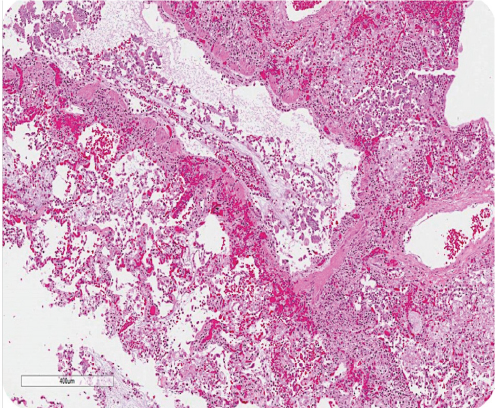
Figure 7: Postmortem finding: longitudinal cross section of a terminal bronchiole filled with mucin and cellular debris.